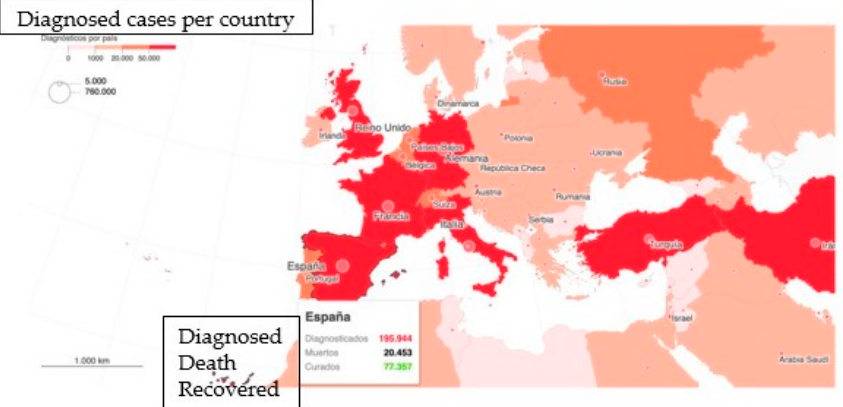
Figure 7. Evolution of the number of deaths in Spain in March and April 2020 by using a hybrid of a bar chart and a frequency polygon [61].